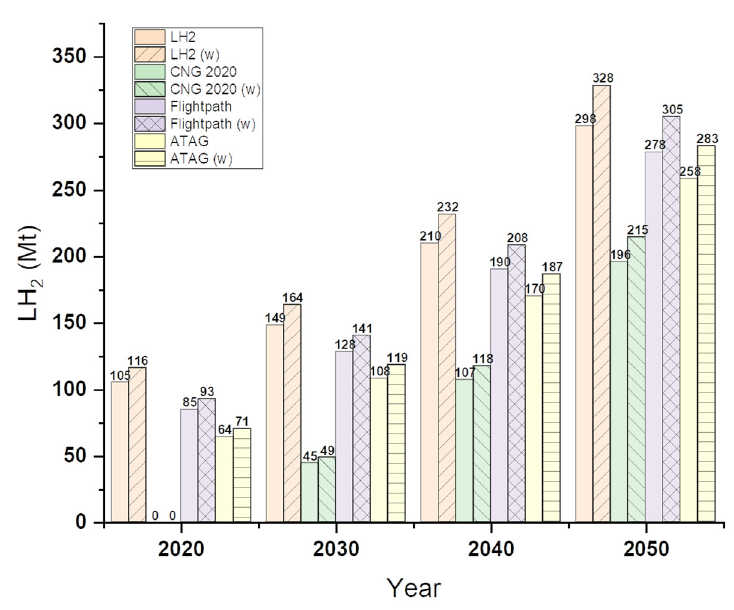
Figure 9. Total estimated LH 2 fuel demand.